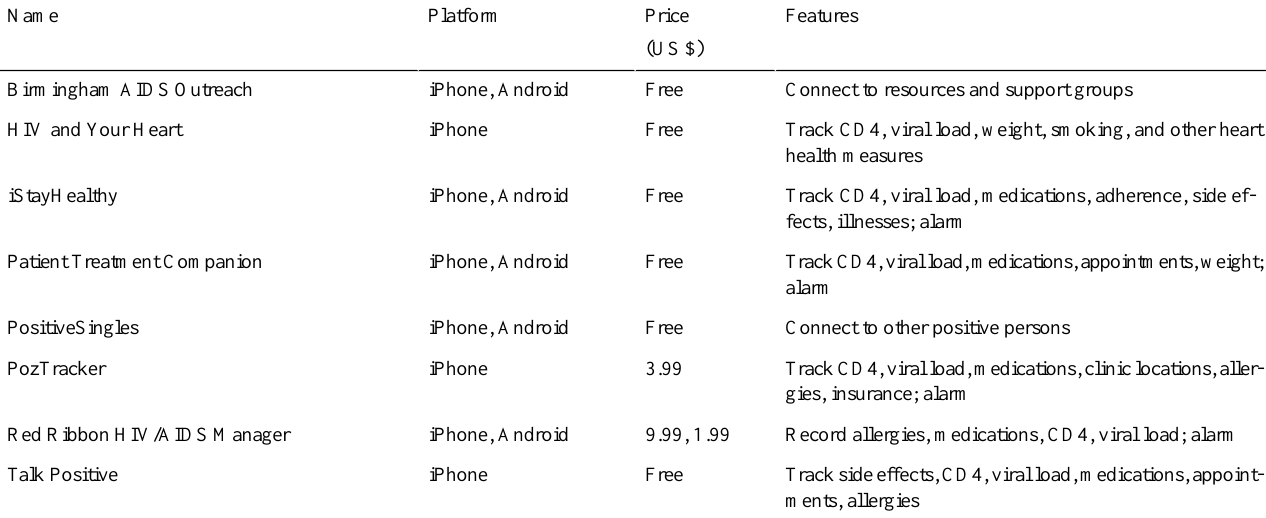
Table 3. Apps for HIV/STD-positive